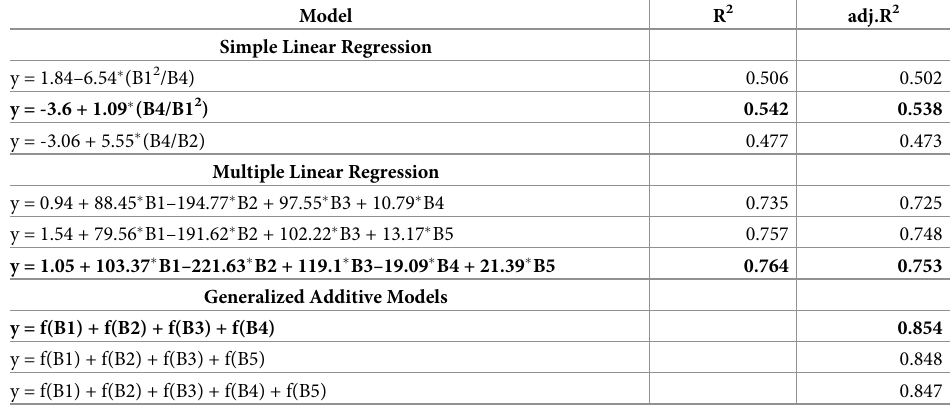
Table 2. Goodness of fit of the three best fitted SLR, MLR, and GAM, respectively, for log-transformed Chl-a estimation. Model R 2 adj.R 2 Simple Linear Regression